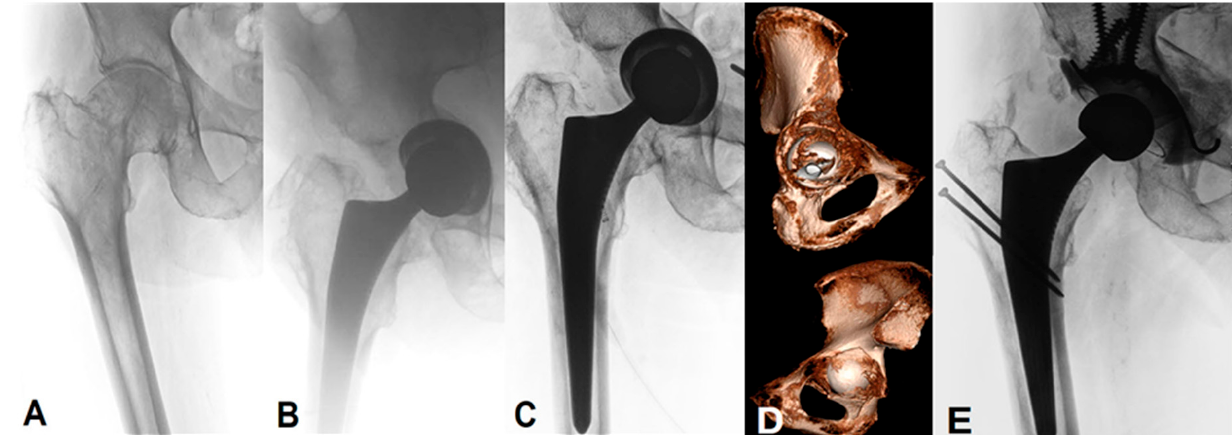
Figure 4. Anteroposterior radiographs and computed tomography images of an 82-year-old man with ( A ) with a symptomatic primary coxarthrosis on the right side. ( B ) Intraoperative anteroposterior view during the primary THA with an interruption of the ilioischial and iliopectineal lines. ( C ) Atraumatic progression of the acetabular fracture with an intrapelvic protrusion of the acetabular component, one day postoperative. ( D ) CT scan was performed for evaluation of the fracture pattern and the preoperative planning, showing a AAOS type IIB fracture by the presence of an extensive central defect. ( E ) Postoperative radiograph after the revision with a trochanteric flip osteotomy, a change of the acetabular component and the use of a Ganz reinforcement ring, and a structural and morselized bone allograft.